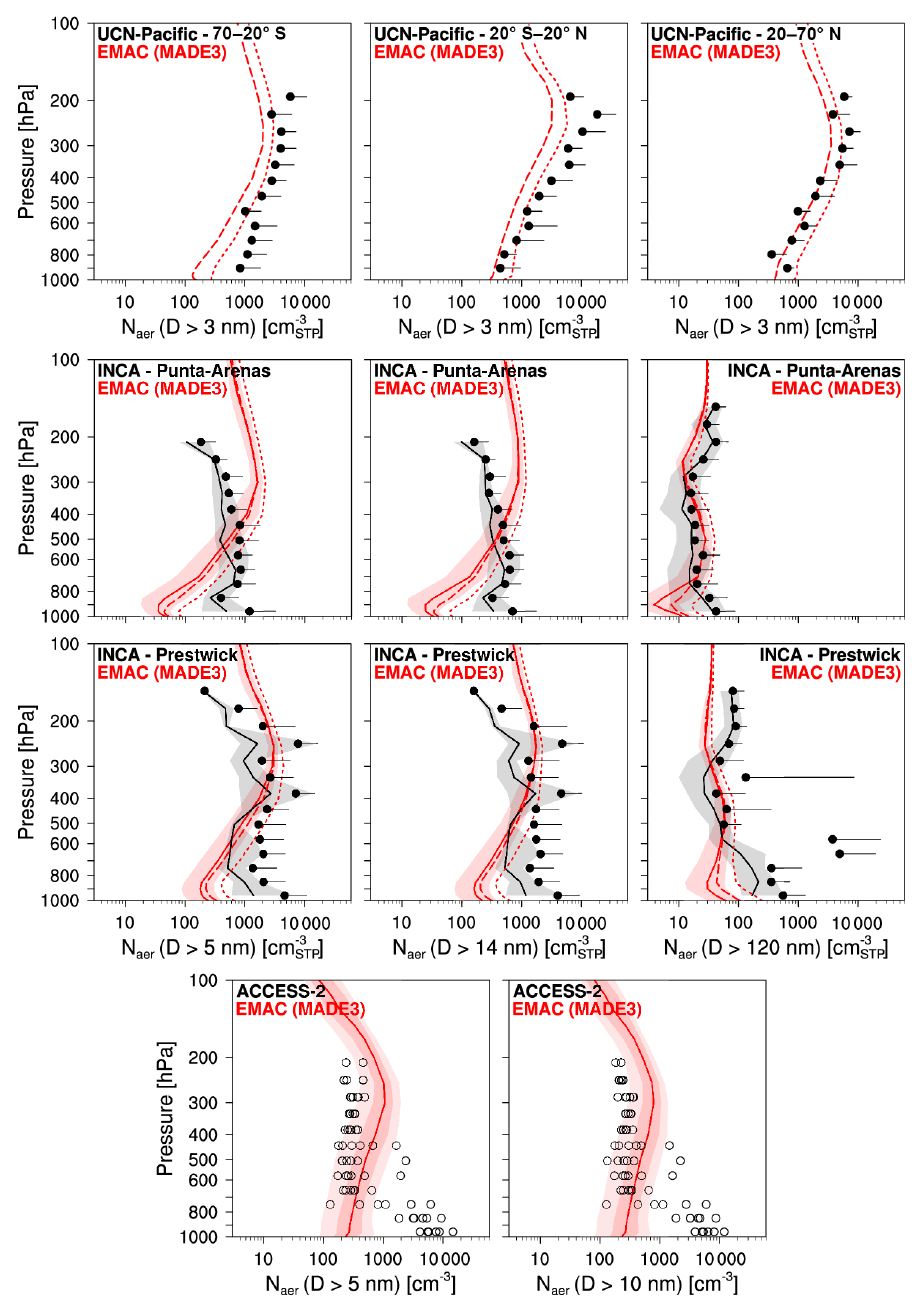
Figure 6. Same as Fig. 5 but for aerosol particle number concentrations with various cutoff